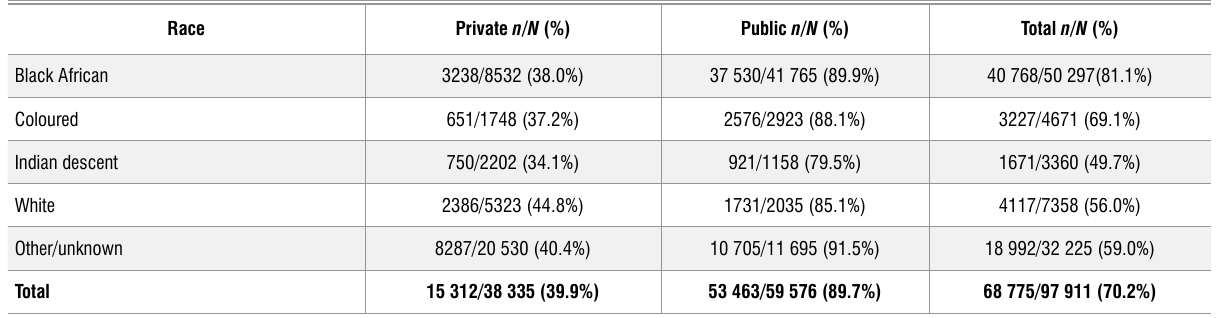
Table 7: COVID-19 in-hospital deaths not treated in ICU by race group, South Africa, 5 March 2020 to 8 January 2022 ( N =97 911)